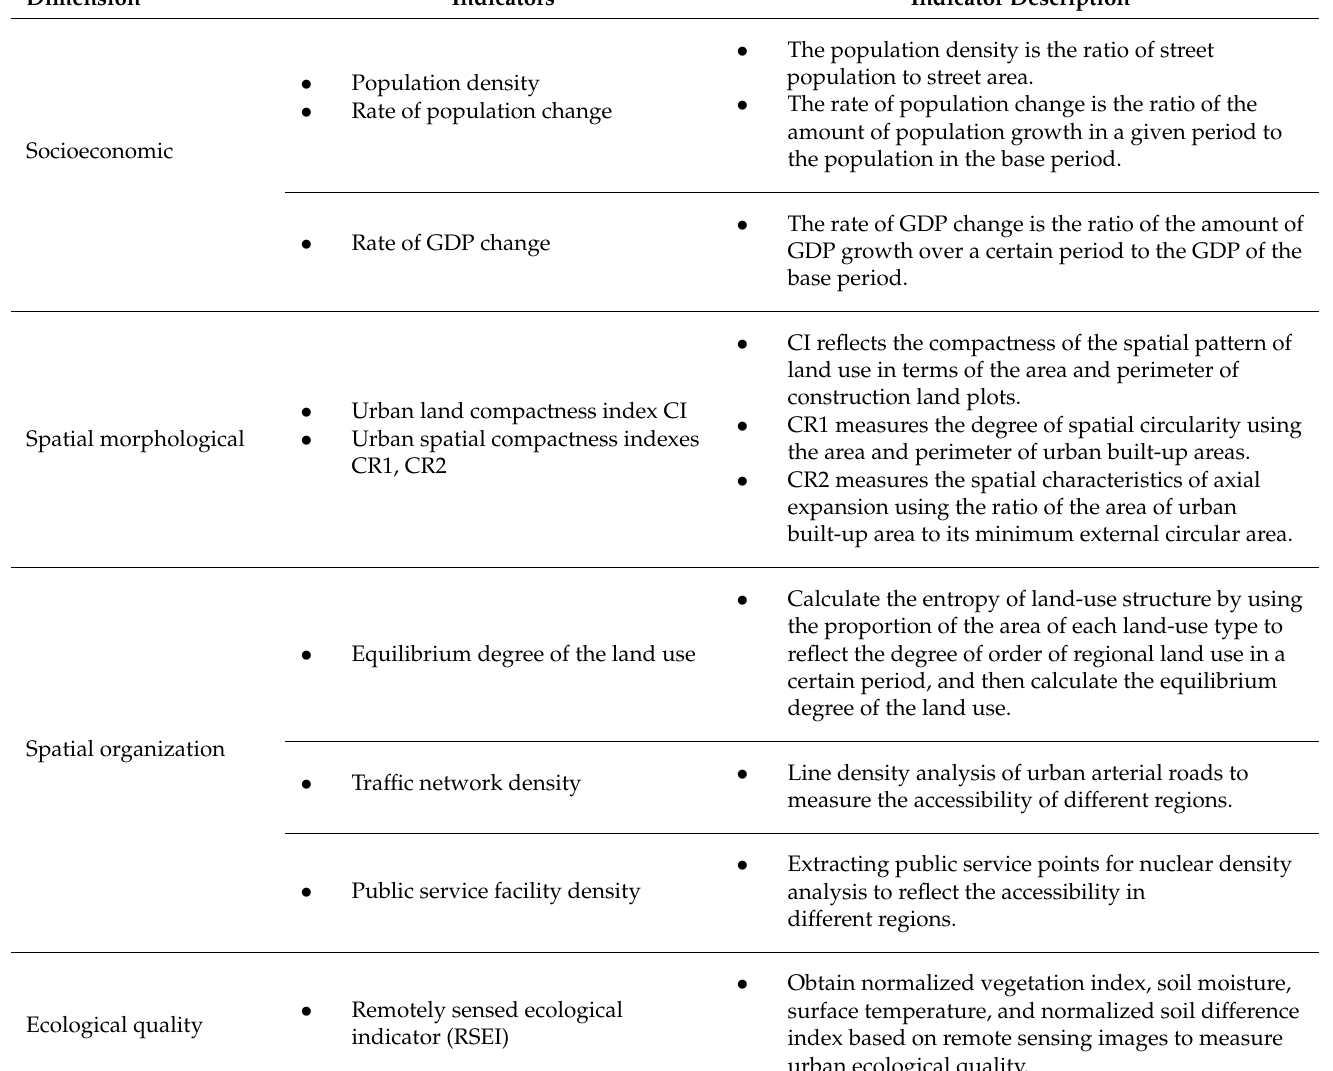
Table 1. The spatial performance evaluation